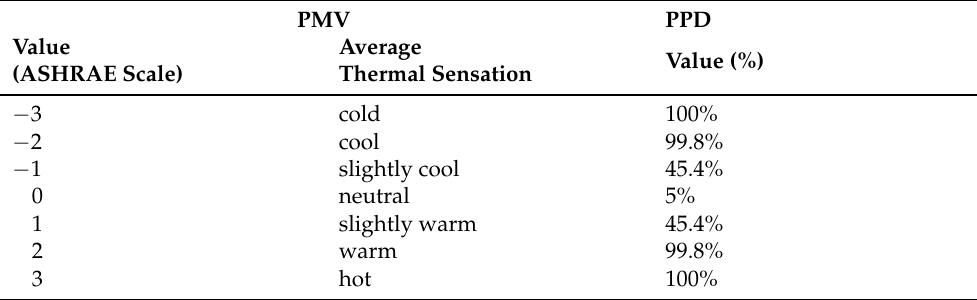
Table 1. Values of predicted mean vote (PMV) and predicted percentage of dissatisfied (PPD).